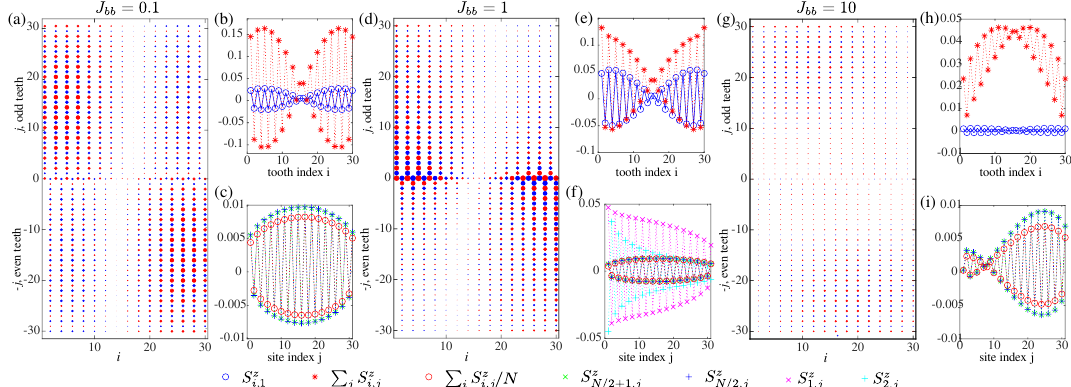
Figure 14: (Color online) Same as Fig.11 but for odd L = 31 and even N = 30. In panel (f) in addition to the average magnetization and central teeth profile, we also show the results on the first and second teeth to highlight that the profiles change along the backbone. In panel (g), with respect to panels (a) and (d), the size of circles were enlarged by a factor of 2.